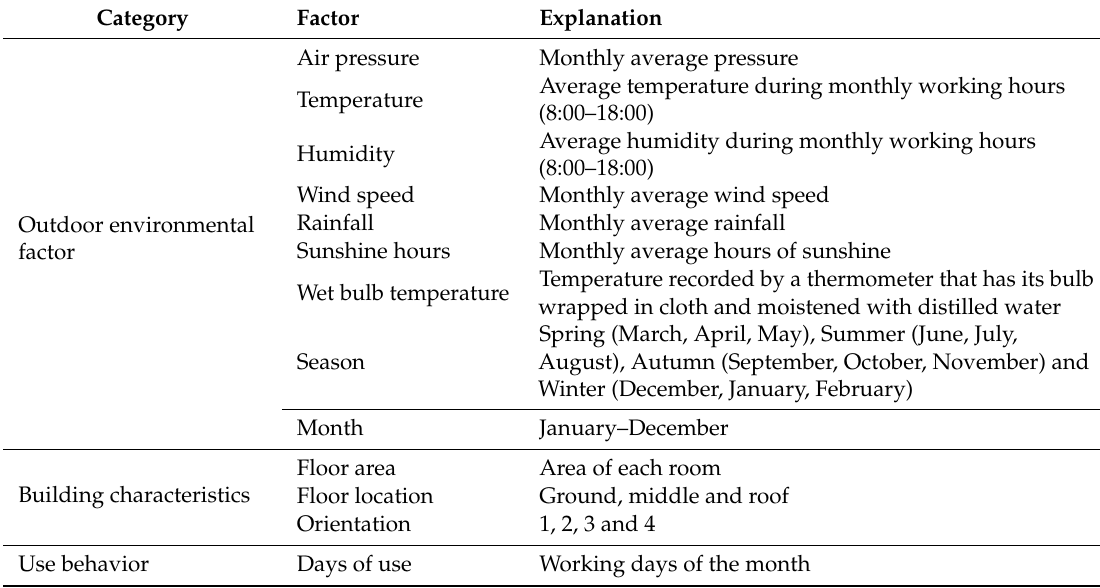
Table 3. The explanation of the causative